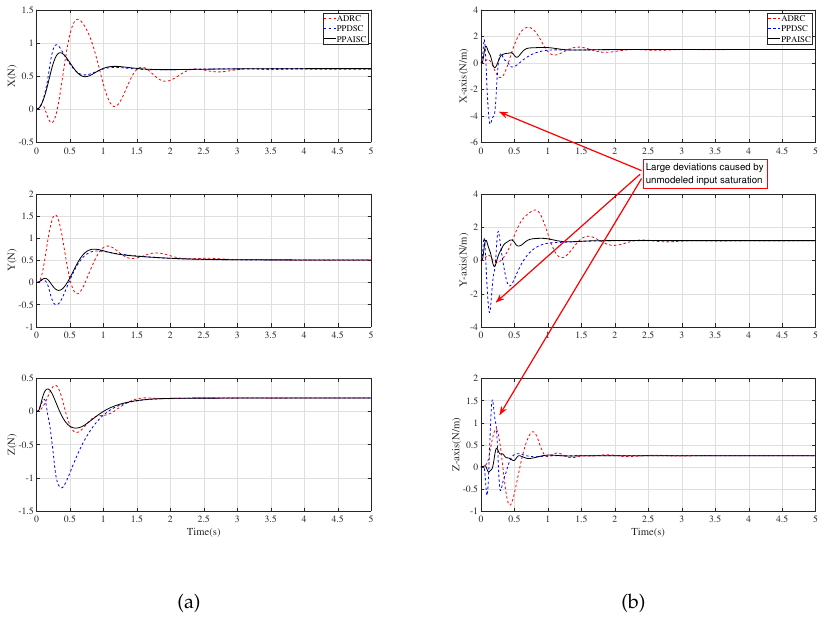
Figure 6. Time responses of disturbance estimation under difference controllers. ( a ) External force disturbances d ξ . ( b ) External torque disturbances d η .